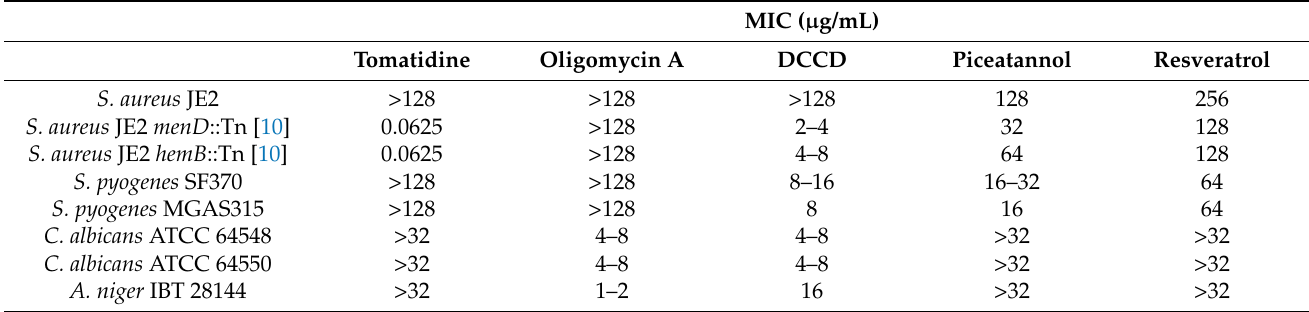
Table 1. Minimum inhibitory concentrations of ATP synthase inhibitors against S. aureus small colony variants, S. pyogenes and the fungal pathogens C. albicans and A. niger .